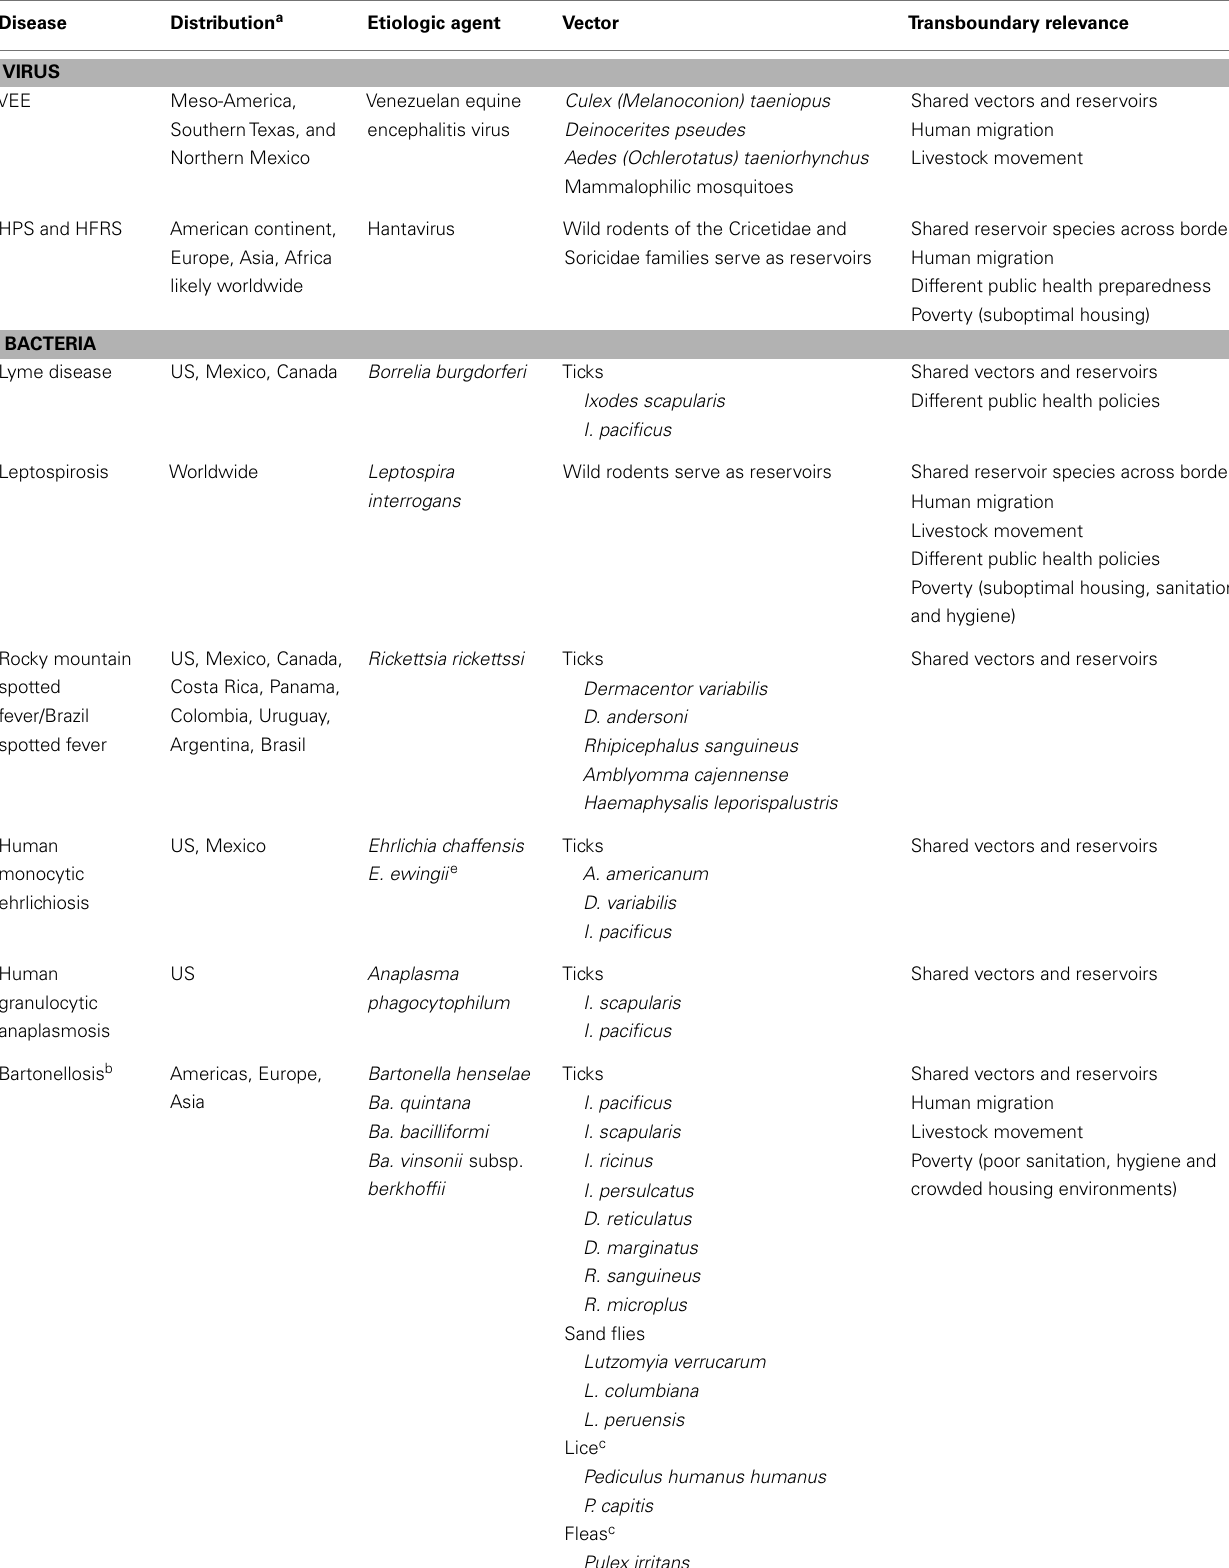
Table 1 |Transboundary zoonotic diseases, distribution, agents, vectors, and transboundary relevance in the US–México border region .